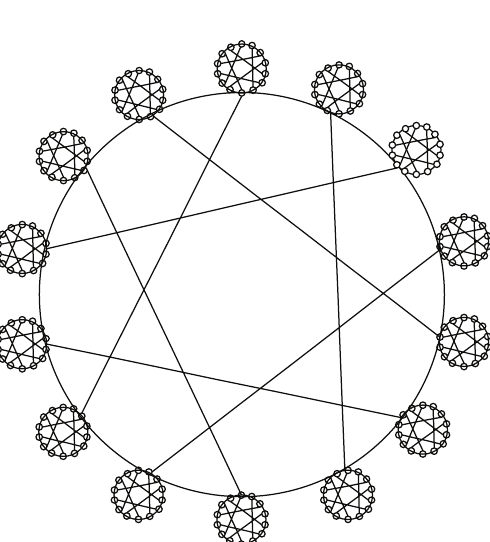
Figure 12: A 2-dimentinal FolH HIN [12].